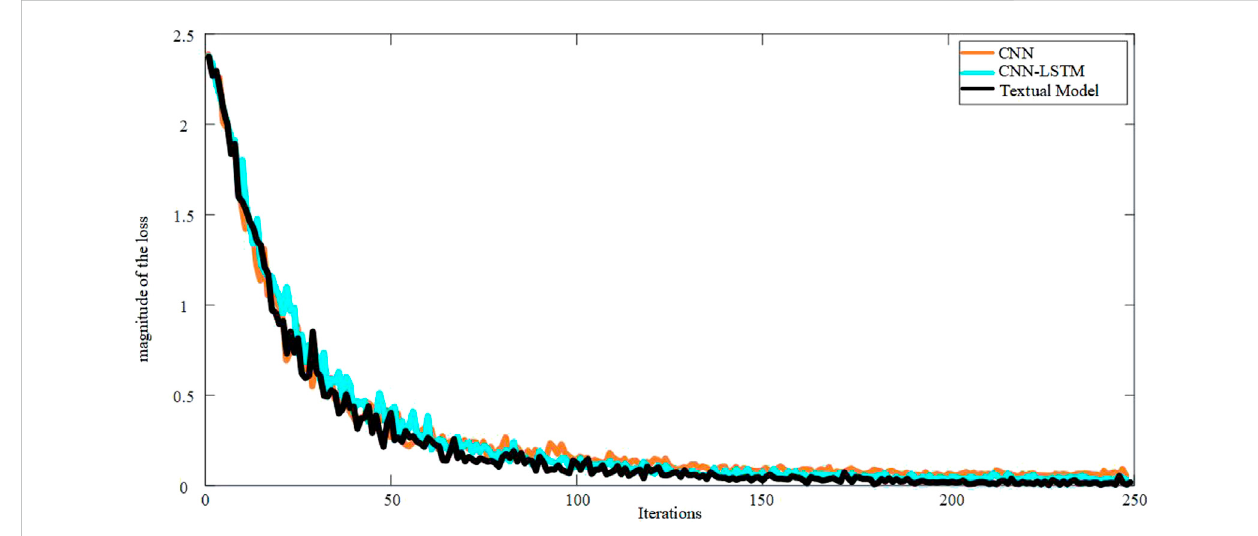
FIGURE 17 Comparison chart of cross entropy loss results in different model training